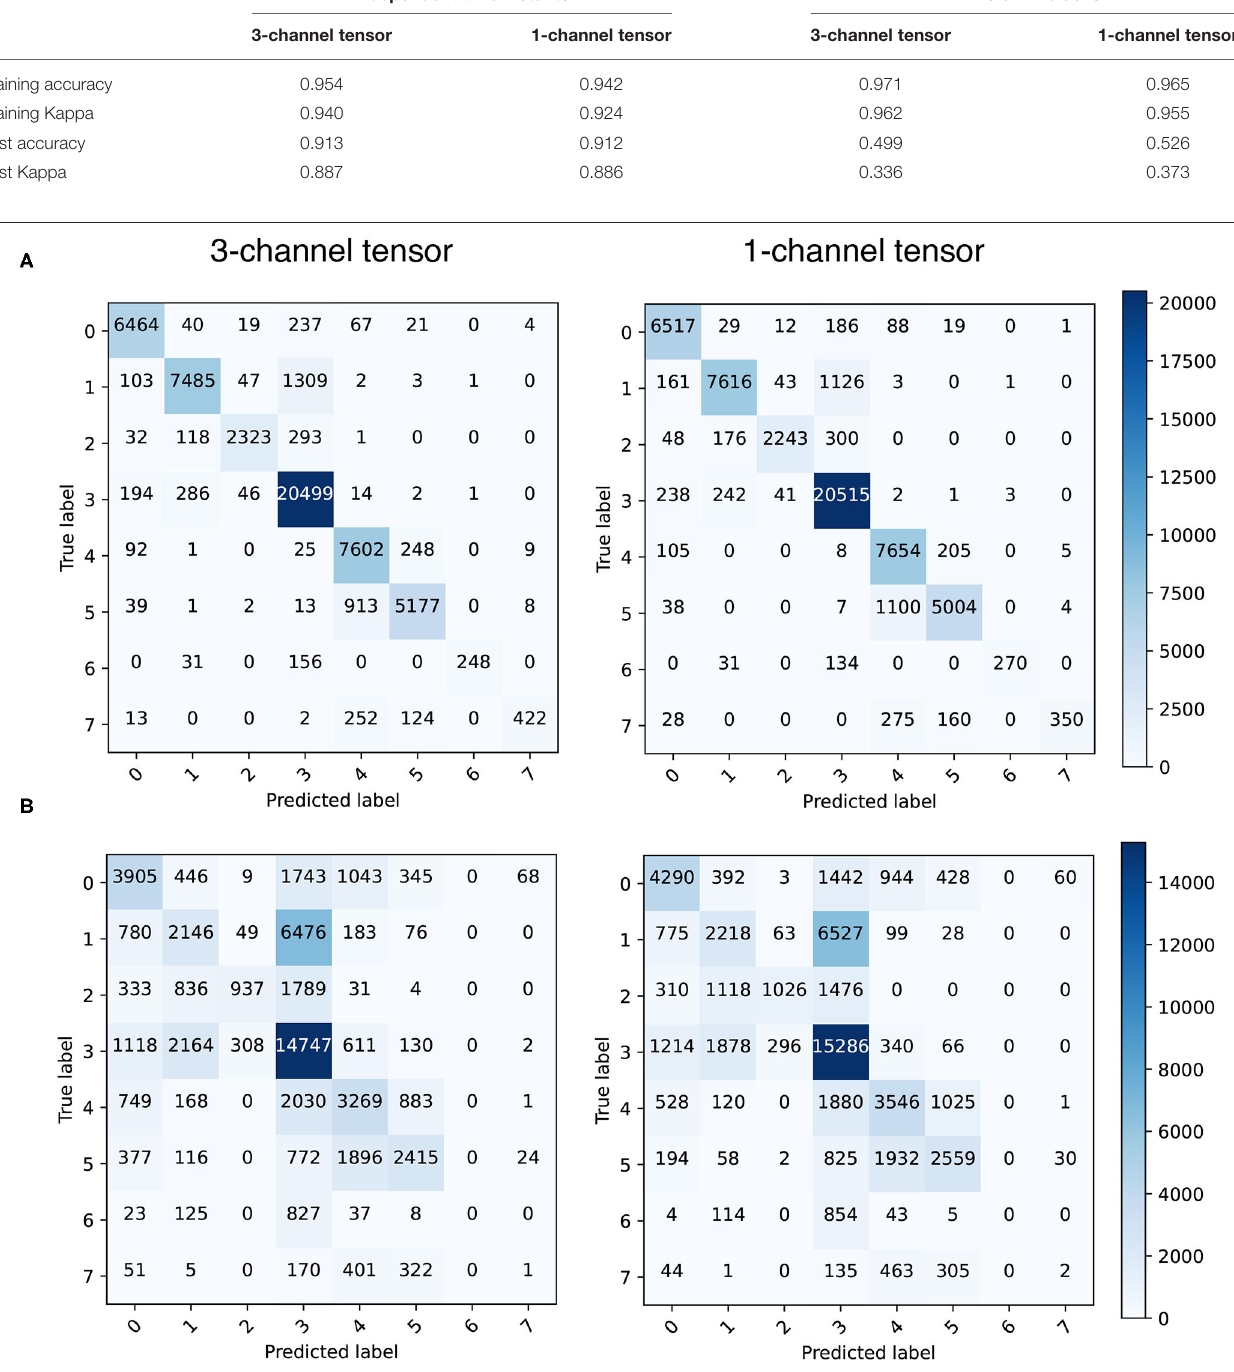
FIGURE 4 | Confusion matrices obtained in the test set (1-channel tensor) for time independence (A) and division in blocks (B) .